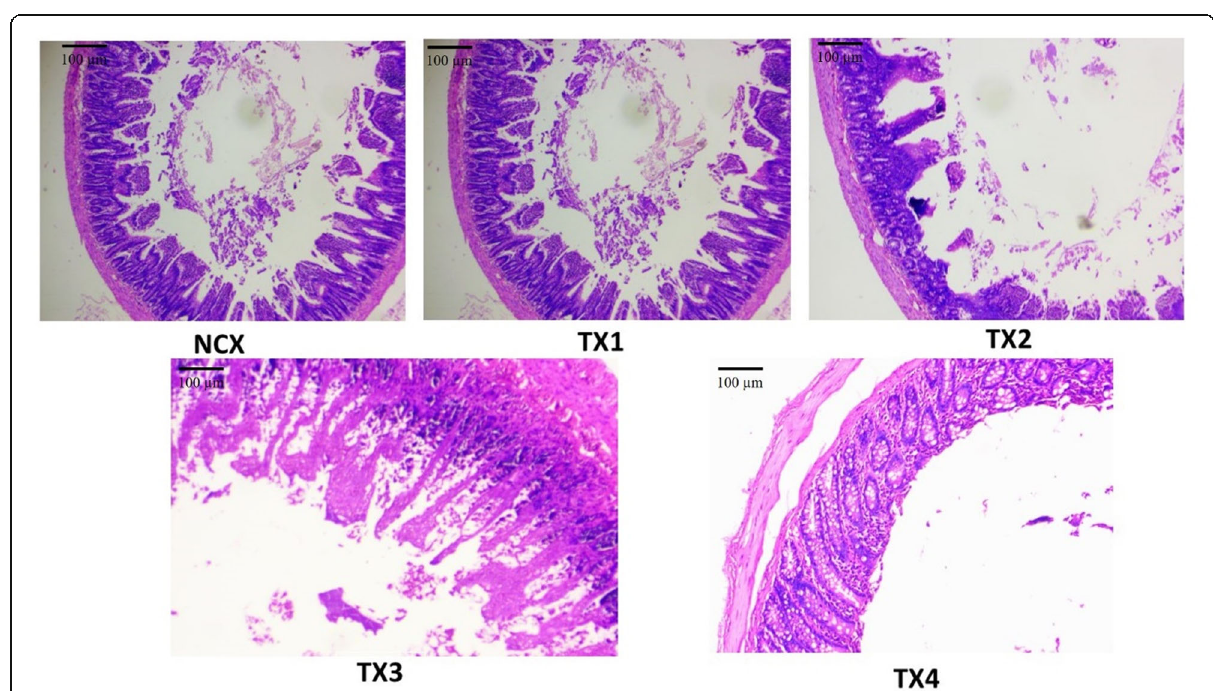
Fig. 5 The histopathology of small intestine from the different group of swiss albino mice (40 × magnification; Scalar bar: 100 μ m). No significant damage (villi atropy, inflammation, superficial erosion and crypt hyperplasia) was observed in the tissues of small intestine of any treated groups rats. The histology result displays no abnormalities in the microscopic structure of small intestine when compared to normal control group (NCX). Where NCX: Normal control group; TX1: Sub-acute toxicity group 1 (250 mg/kg/day/p.o); TX2: Sub-acute toxicity group 2 (500 mg/kg/day/p.o); TX3: Sub-acute toxicity group 3 (1000 mg/kg/day/p.o); TX4: Sub-acute toxicity group 4 (2000